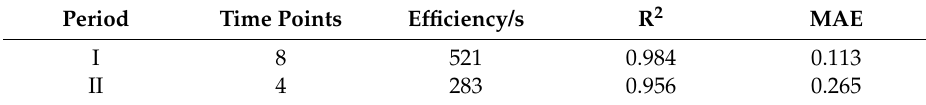
Table 6. Comparison of the accuracy and efficiency between the two assimilation key periods.